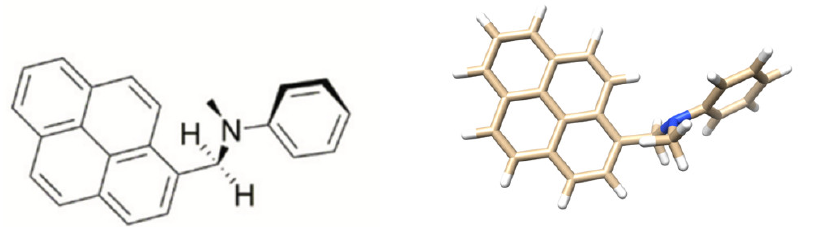
Figure 2. Lewis structure of PyrDMA as well as a 3D representation (Chimera) showing the orthogo- nality of the donor and acceptor (DFT optimized structure in the ground state). ent solvents are indicated in Table 1. Table 1. Experimentally measured rates for charge recombination to the triplet ( k CR different solvents